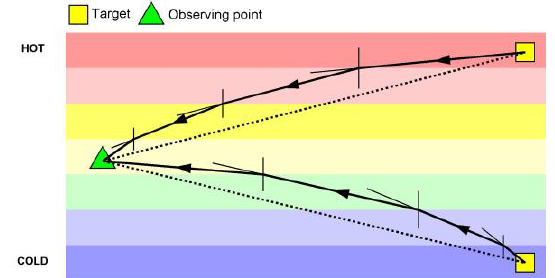
Figure 1. Refraction of a ray of light in layered temperature